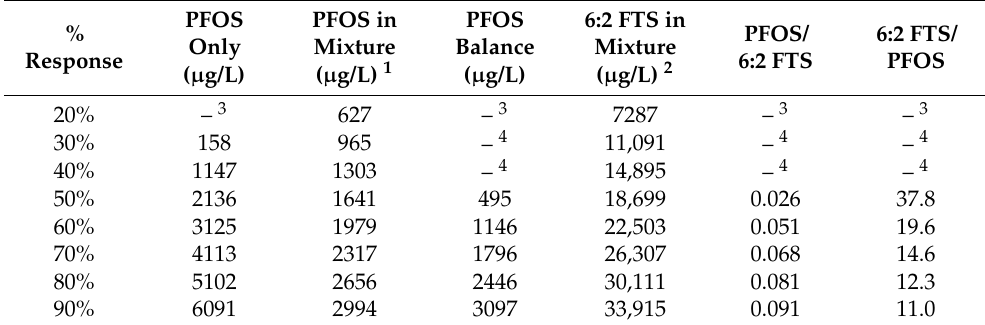
Table 6. Estimate of the PFOS equivalent dose to determine the relative potency factor for 6:2 FTS from the binary mixture